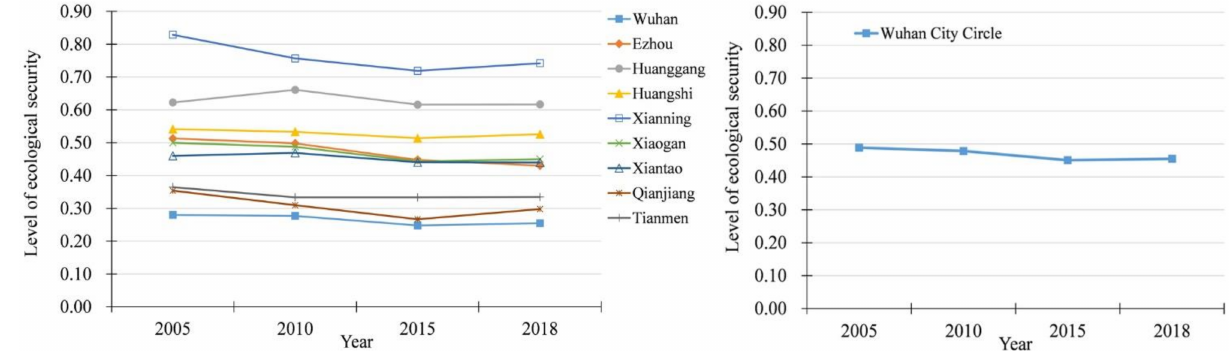
Figure 4. The changes of ecological security level in Wuhan City